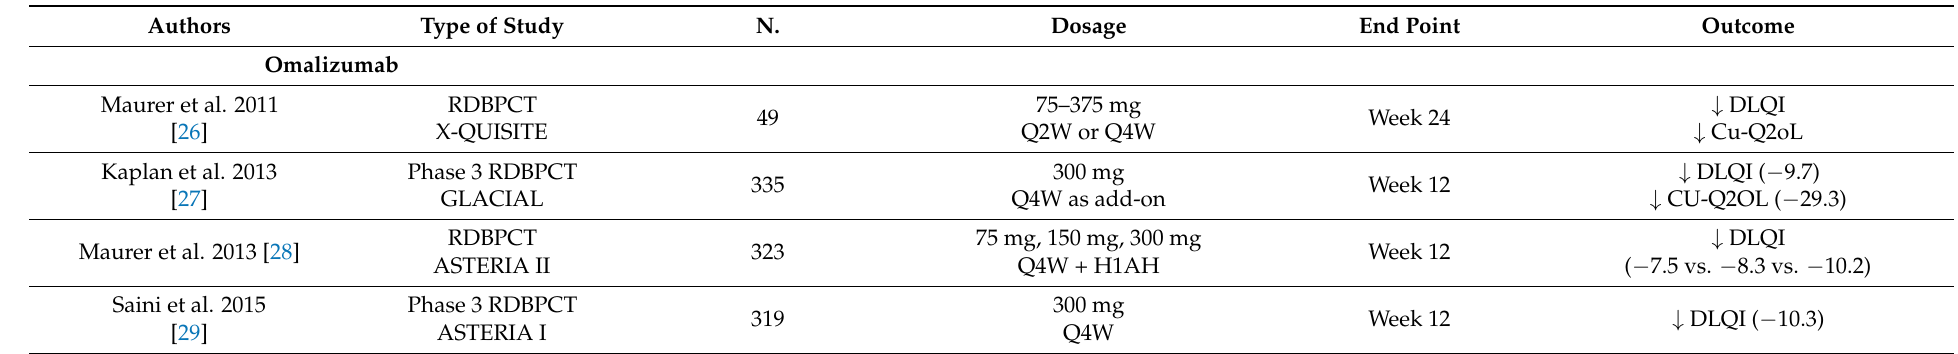
Table 4. List of the studies on biologics in CSU reporting the HR-QoL score as an